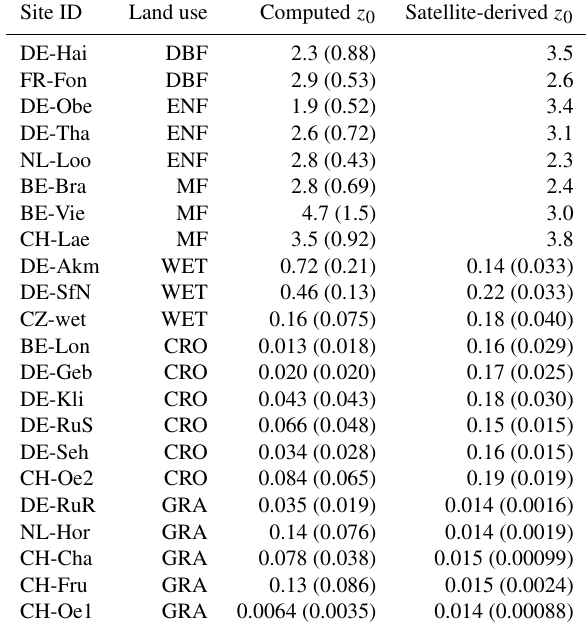
Table 6. Comparison of the computed z 0 values from FLUXNET observations and the corresponding satellite-derived z 0 values. The table shows the mean and standard deviation of all z 0 values in 1 year. For forest, only the maximum z 0 value is